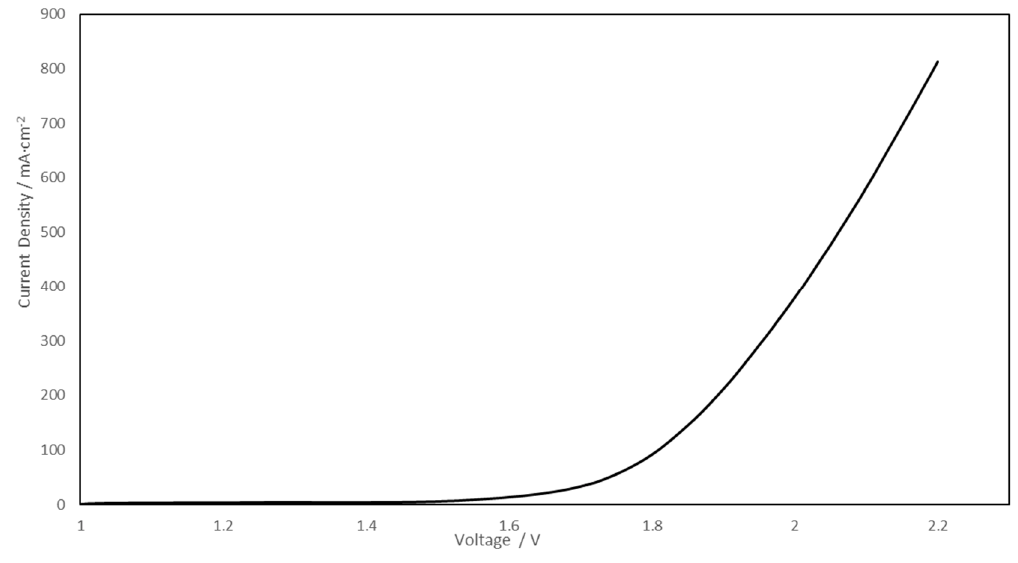
Figure 5. Polarization curve of the experimental AEMWE.